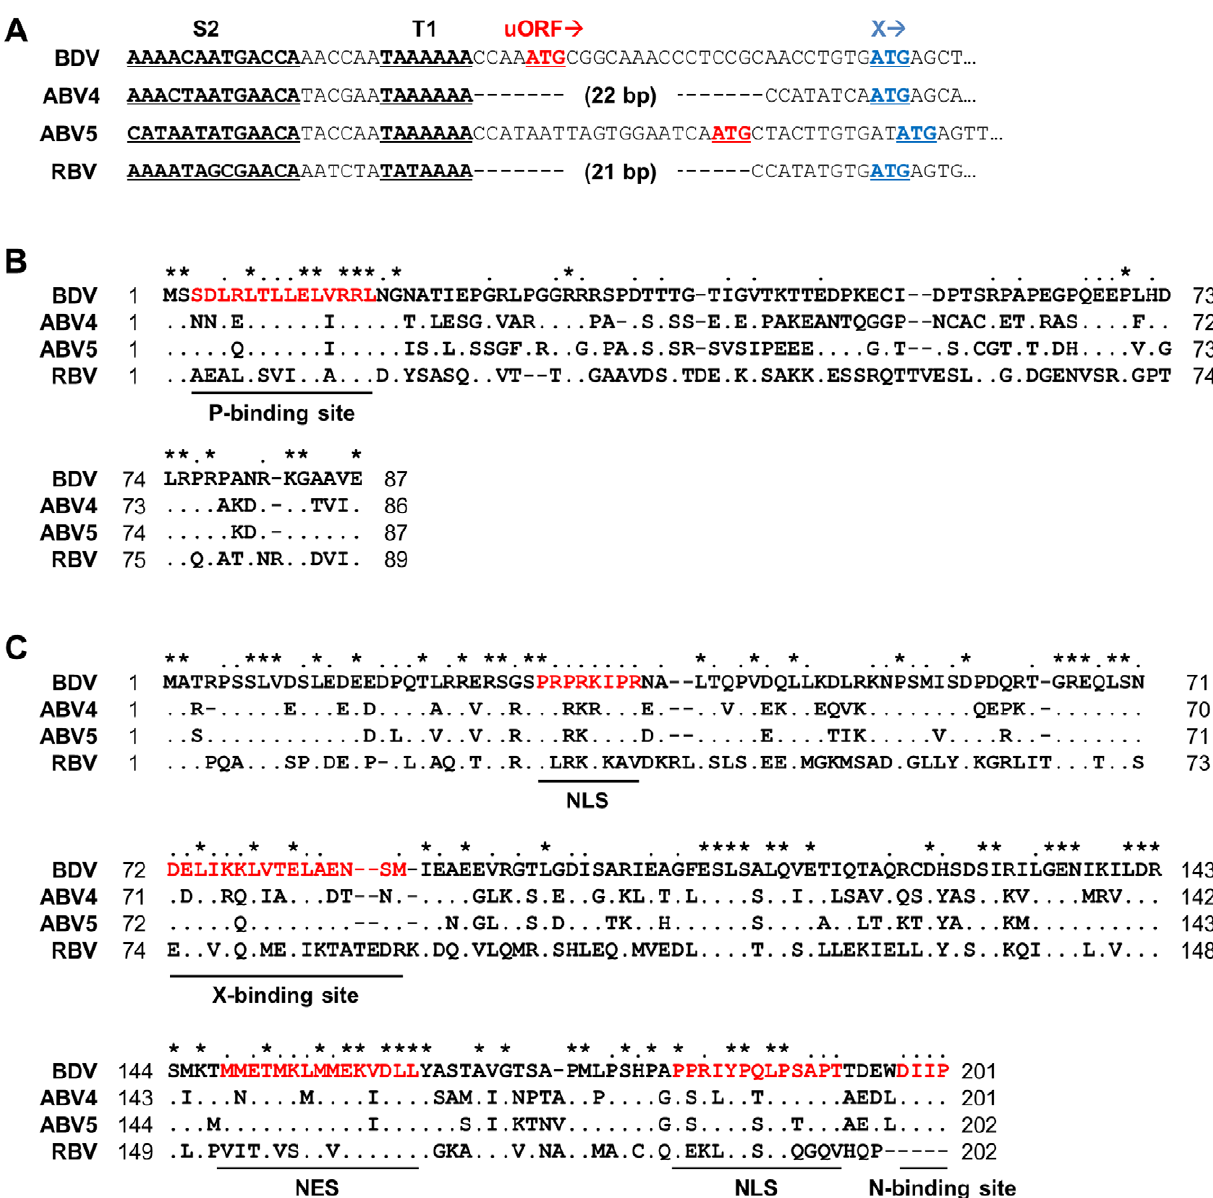
Figure 2. Sequence comparisons among bornavirus genotypes. (A) Nucleotide sequence alignment of the region between the N and X ORFs. The stop and start codons of the BDV N and X genes, respectively, are shown. The start codon of the BDV uORF and the proposed uORF of ABV5 are indicated in red. The S2 transcription initiation and T1 termination sites of BDV and their corresponding sequences in non-mammalian bornaviruses are underlined. (B and C) Amino acid sequence alignments of X (B) and P (C) among bornavirus genotypes. Amino acids identical to the BDV sequences are indicated by dots. Gaps are indicated by dashes. Sequences identical in four and three genotypes are indicated by asterisks and dots, respectively, above the sequences. The regions of NLS, NES and putative binding sites for each protein are